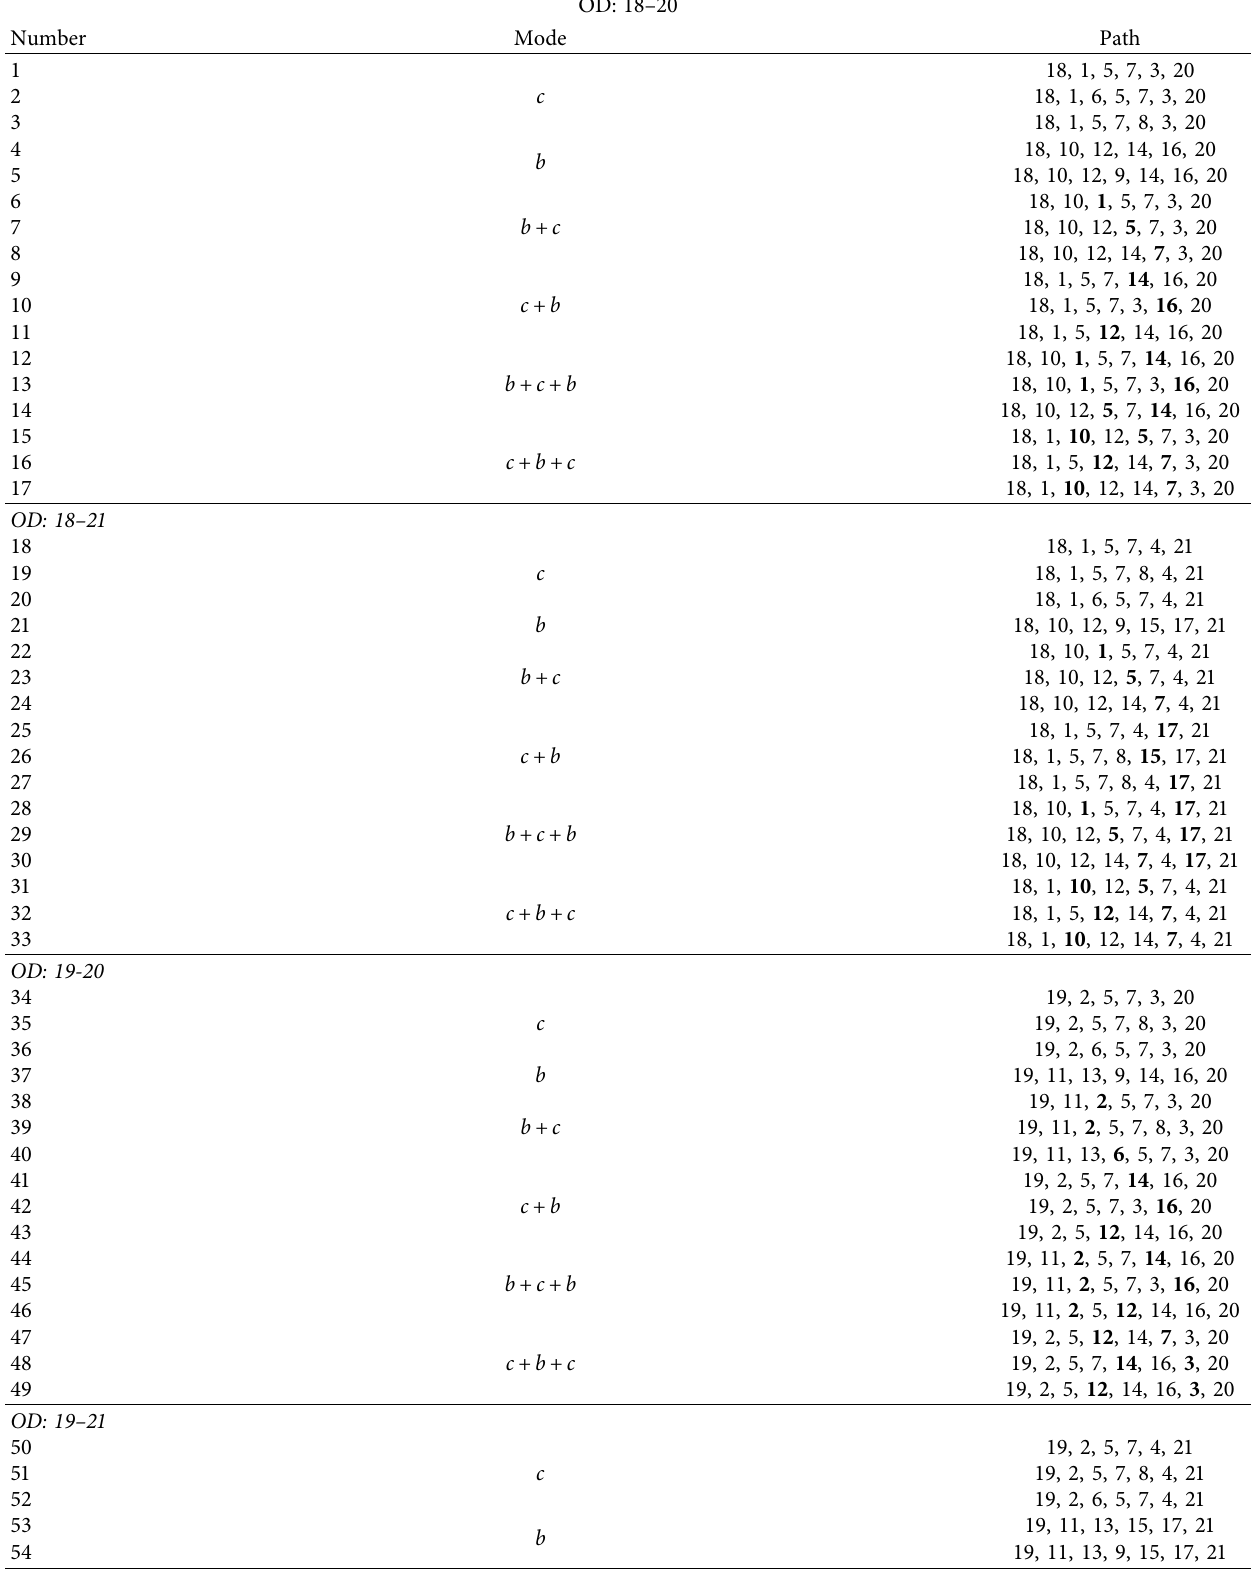
Table 3: Path set of experiment